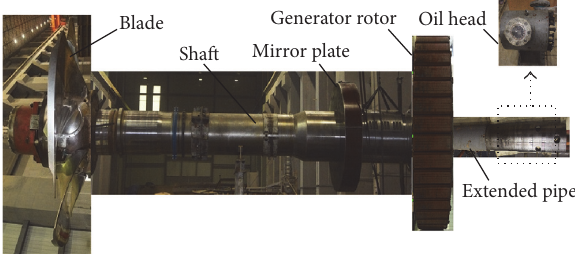
Figure 10: Prototype of hydroelectric